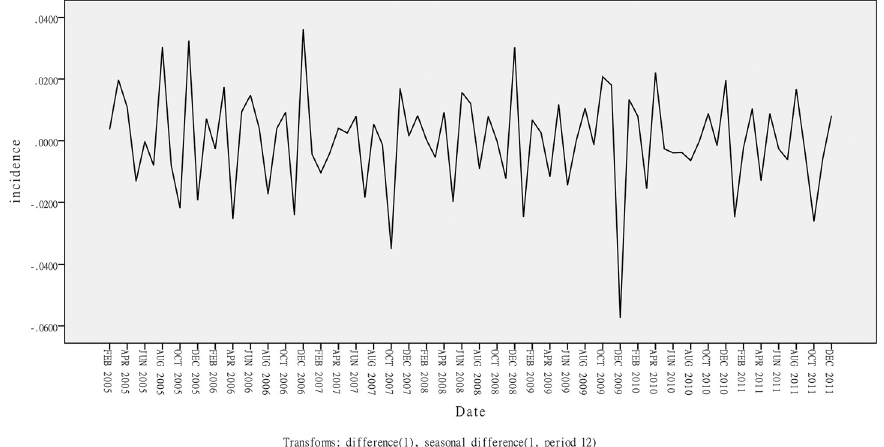
Fig 2. Transformed time series of monthly HFRS incidence. A first-order regular difference and a first seasonal difference were used to transform the raw series into a stationary one.